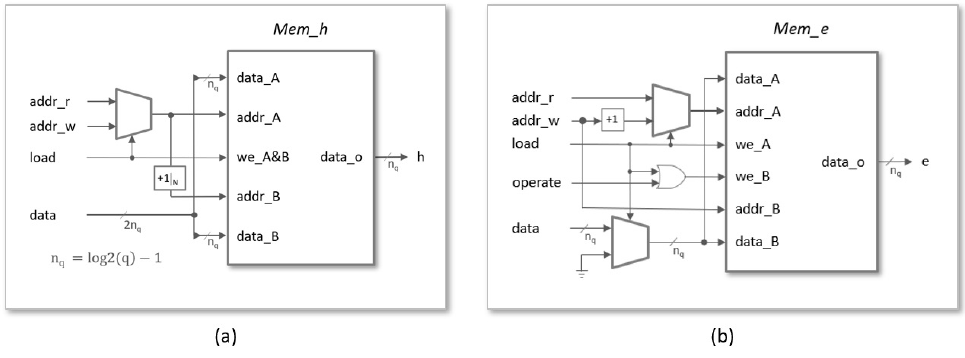
Figure 7. Basic memory blocks used to store the coefficients of polynomials h ( x ) ( a ) and e ( x ) ( b ).